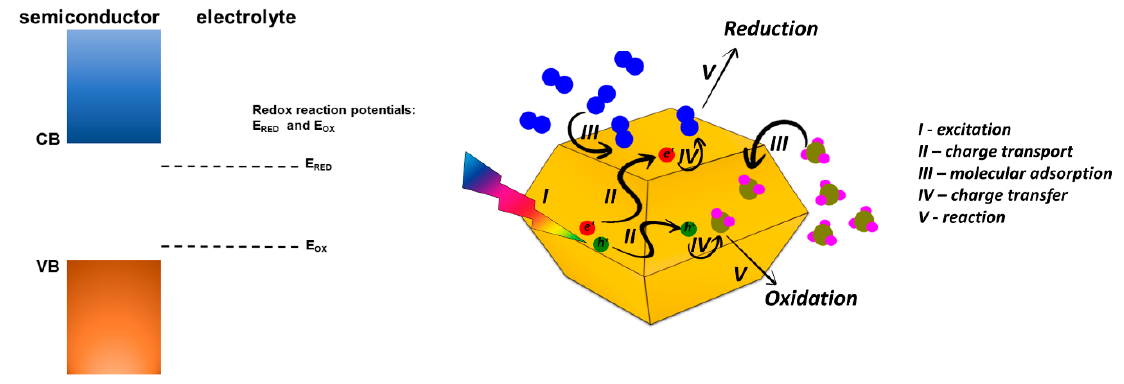
Figure 4. Schematic illustration of photocatalytic processes with facet-dependent photogenerated charge separation.